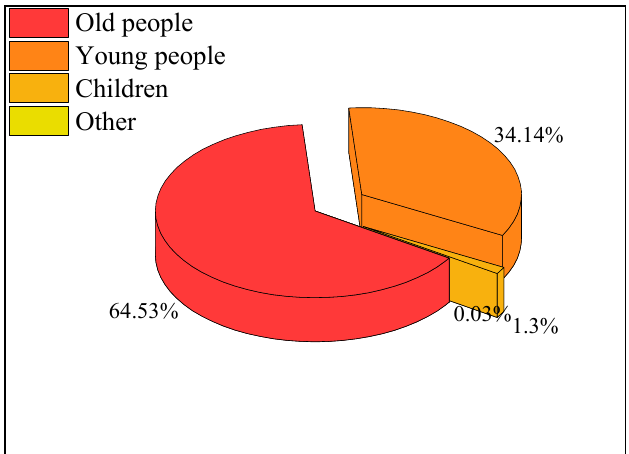
Figure 3. Crowd composition of cruise ships.